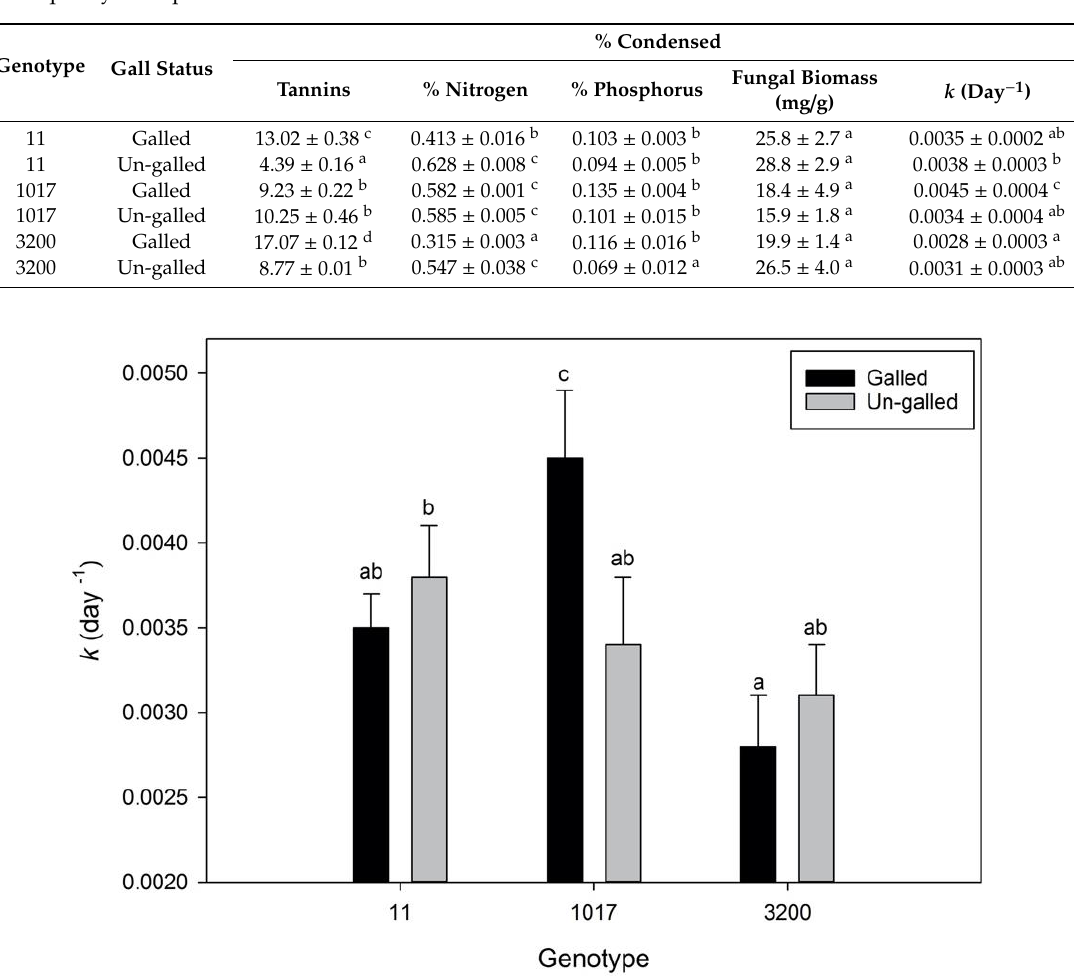
Table 3. Initial leaf litter chemistry (% condensed tannins, % nitrogen, % phosphorus) values, fungal biomass (mg / g) at day 17, and decomposition rate constants ( k day − 1 ; across entire 189 day study) for galled and un-galled litter of three cottonwood backcross hybrid genotypes. Chemistry values represent means ± 1 S.E. ( n = 2), fungal biomass values represent means. ± 1 S.E. ( n = 5), decomposition rate constants ( k ) represent the slopes of the exponential regression lines ± S.E. for the slope ( n = 5). Lower case letters denote significant di ff erences at an alpha of 0.05 following a Tukey’s HSD test, or an equality of slopes test in the case of k .